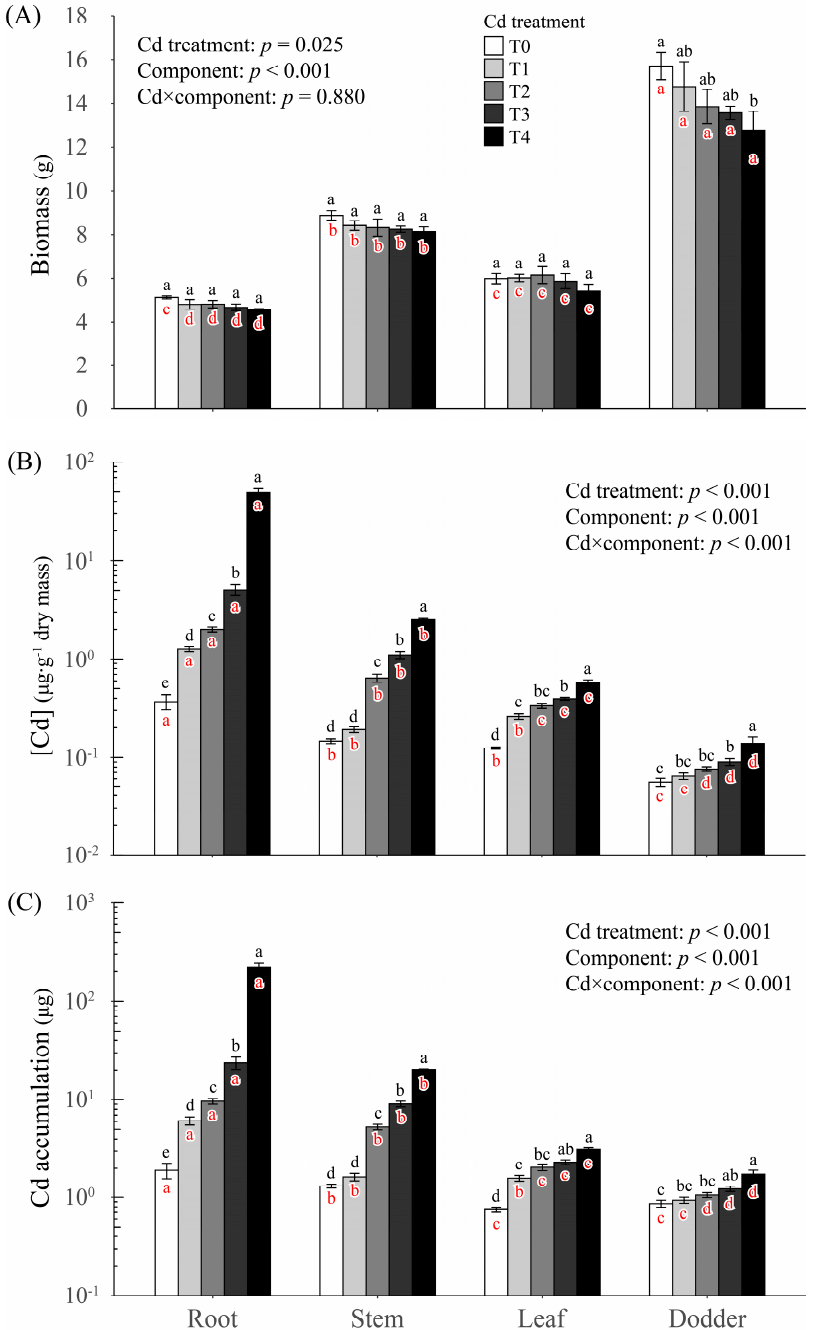
Figure 1. The effects of cadmium (Cd) treatment and component type on the ( A ) biomass, ( B ) Cd concentration ([Cd]) and ( C ) Cd accumulation of various components within the soybean-dodder parasitic systems. The levels of Cd treatment were applied as Hoagland solution (50% strength) amended with 0, 1, 10, 100, and 1000 mg·L − 1 CdCl 2 , which are respectively marked as T0, T1, T2, T3, and T4. The analyses were performed using nested two-way ANOVAs with Cd treatment, component type and their interaction term as fixed factors, and pot replicate as a random factor, followed by Tukey’s post hoc tests. The results are presented here as p values of fixed factors, which were calculated based on type-III analysis-of-variance. Different black letters within one component type indicate significant differences between Cd treatment levels of that component. Different red letters within one Cd treatment level indicate significant differences between components under that treatment level. The error bars denote 1 SE of the mean.